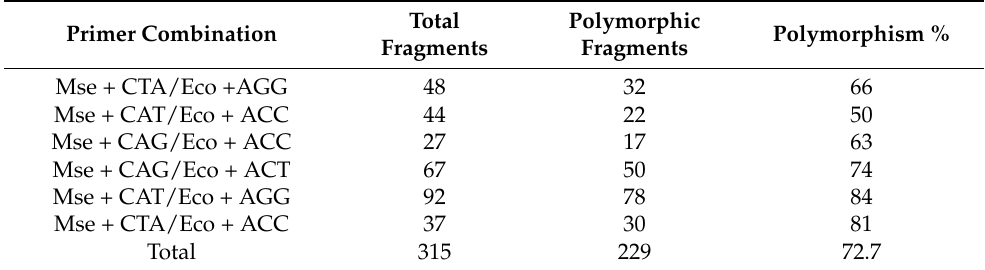
Total Polymorphic Polymorphism % Fragments Fragments